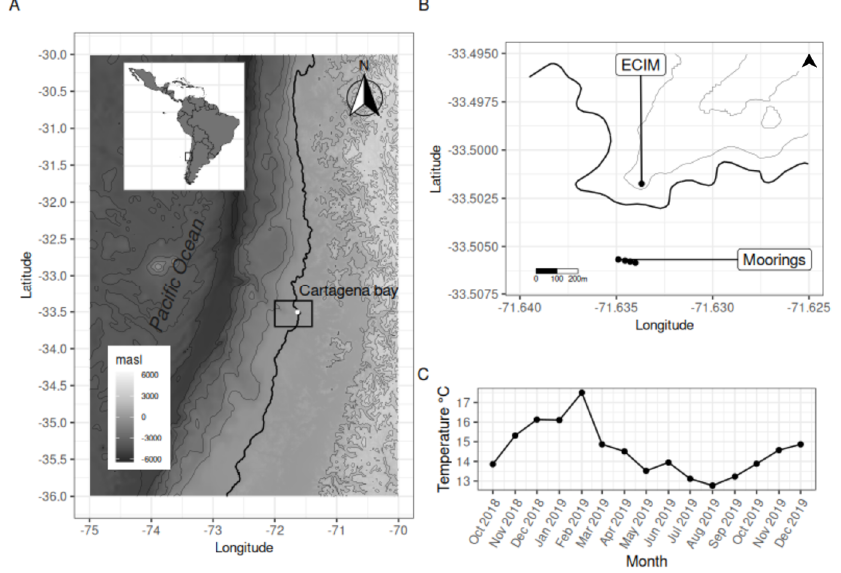
Figure 1. ( A ) Map of study site at Bay of Cartagena in central Chile. ( B ) Position of the four moorings (the plates are facing the compass direction). ( C ) Seawater average temperature at 5 m deep between October 2018 and December 2019.